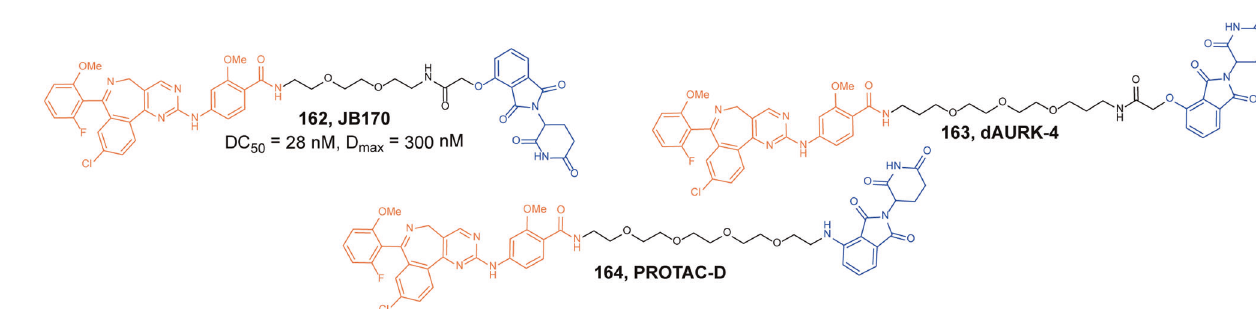
Fig. 41 The representative PROTACs targeting Aurora A